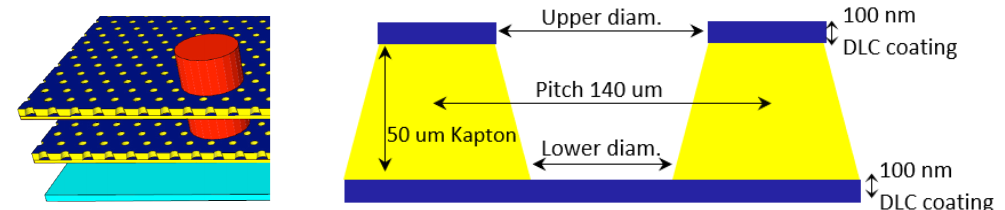
Figure 1. ( Left ): sketch of a 2-layers Fast Timing Micro-Pattern Gaseous Detector (FTM) (without upper drift electrode). ( Right ): detailed view of the amplification